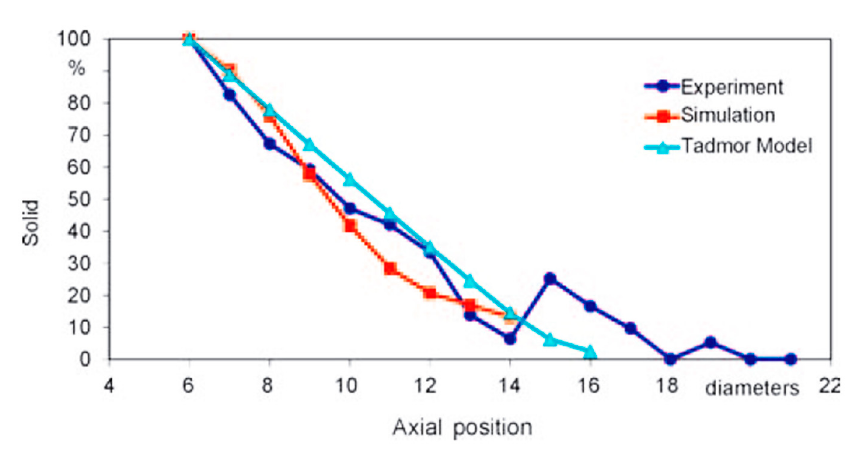
Figure 10. Experimental, CFD, and analytical predictions of the solid content in screw vanes of an IM extruder—reprinted with permission from [10].